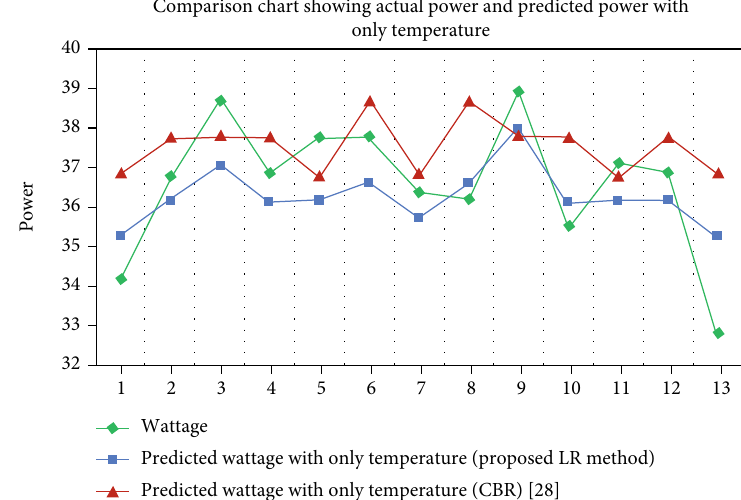
Figure 17: Comparison chart showing actual power and predicted power with only temperature.